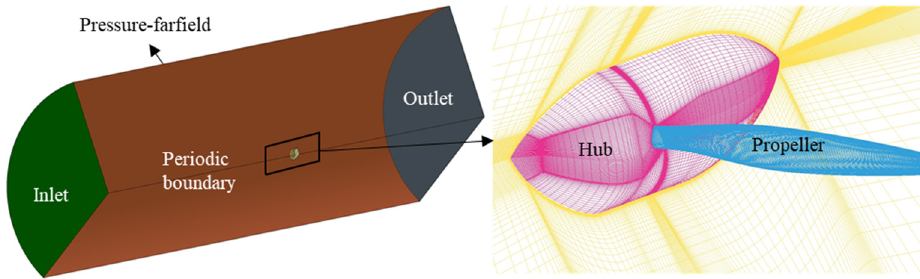
Figure 9. Structural grid of the 3-blade NACA 5868-9 propeller for 3D CFD simulation.